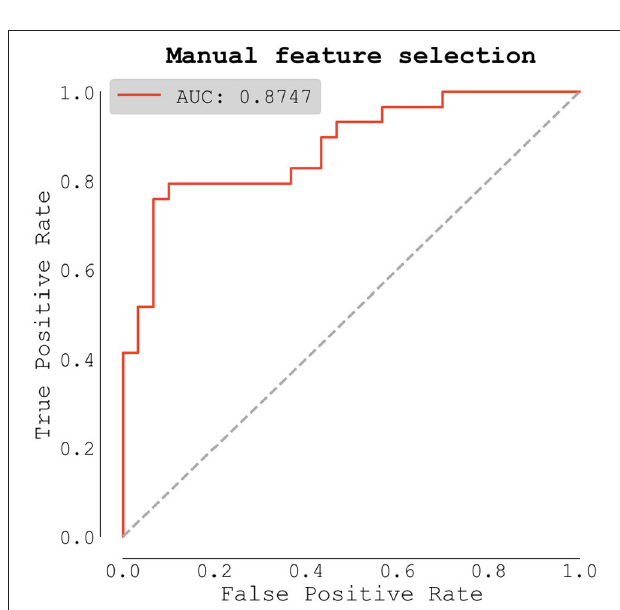
FIGURE 4 | Logistic regression model (all patient data).